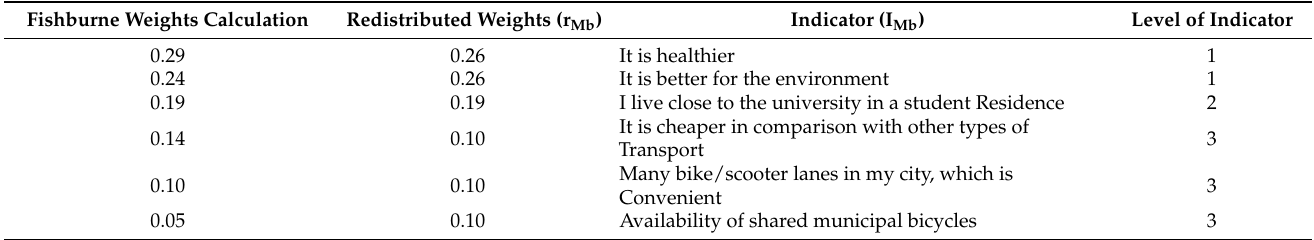
Table 23. Reasoning indicators for municipal bicycle/electric scooter.